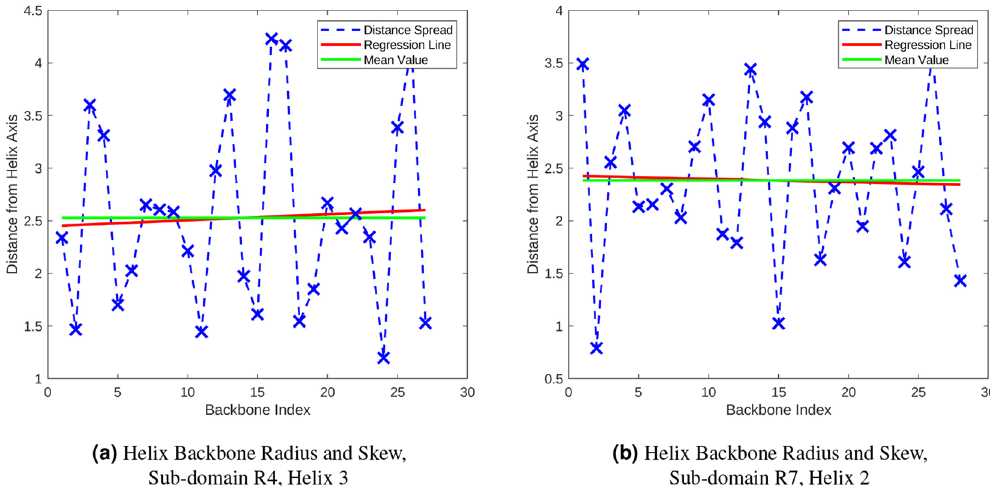
Figure 2. ( a , b ) The distances between each of the original backbone (C α ) positions and the centre axis of the helix are shows. These plots allow the changing width of the alpha-helix backbone to be visualised. The green line represents the mean distance to the alpha-helix backbone from the centre axis. This is the value used for the width of the alpha-helix within our model. The red line shows the skew in the distance data along the length of the helix. A large difference in angle between the skew line and the mean line indicates that a helix’s width changes along is length. (MATLAB, 2020b, https:// www. mathw orks.